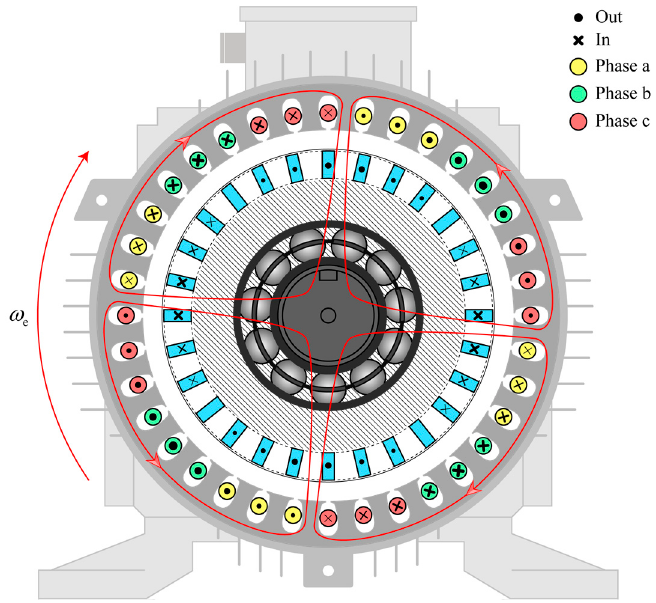
Figure 1. Structure of a 3-phase, 4-pole induction motor.